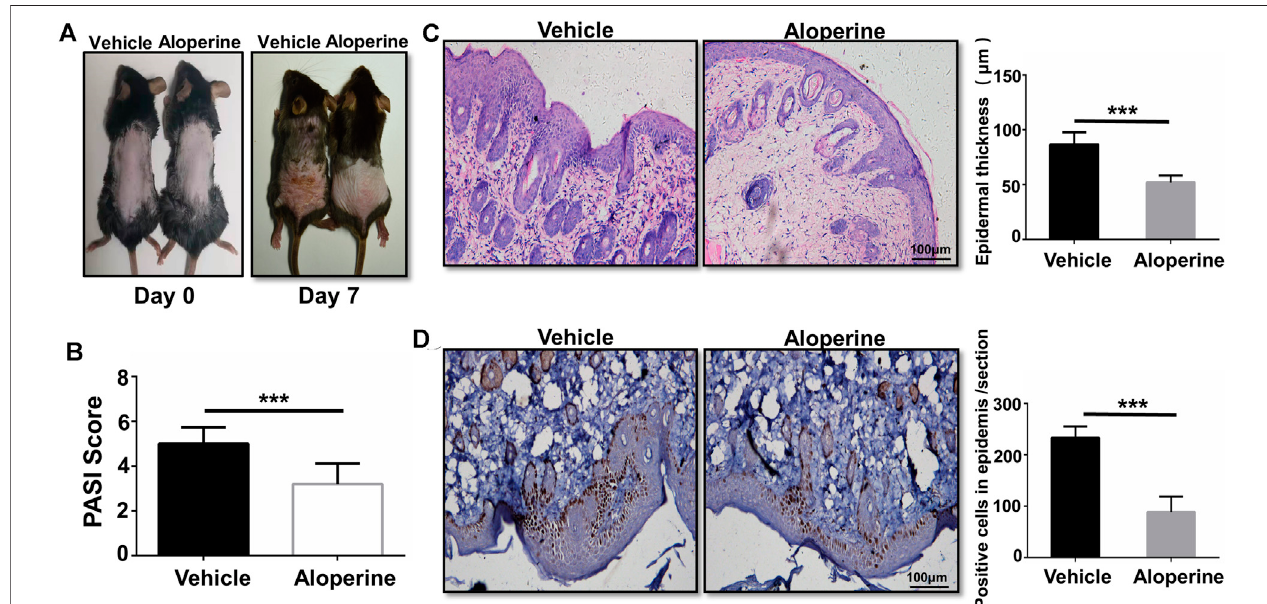
FIGURE 1 | Topical application of aloperine ameliorates psoriasis induced by IMQ. (A) Representative presentation of the back skin at day 7 of the IMQ treatment. (B) The severity was graded by a modi fi ed PASI. (C) Histological analysis of the mouse back skin by H&E staining. (D) Histological analysis of IHC staining for Ki-67. Correspondingquanti fi cationanalysesofepidermalthicknessandpositiveproliferationcellswerecarriedoutasdescribed.Thevaluesarepresentedasthemean±SEM ( n = 10 mice per group). p p < 0.05; pp p < 0.01; and ppp p < 0.001.